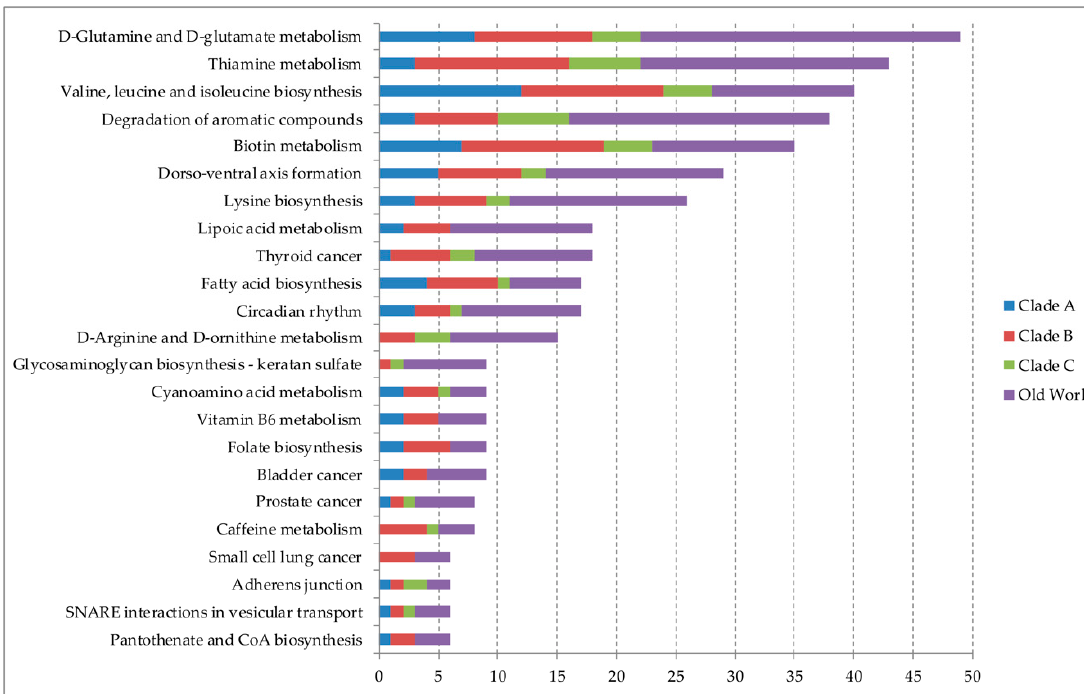
Figure 1. Top 20 main signaling pathways predicted to be regulated by microRNAs targeting mammarenavirus genome. The representative proportion of each pathway individually for the four clades (Clade A, B, C, and Old World) is shown. The graphic scale is represented by the number of microRNAs that were found interacting with each pathway. The larger the scale, the greater the number of microRNAs found that are regulating a specific pathway.